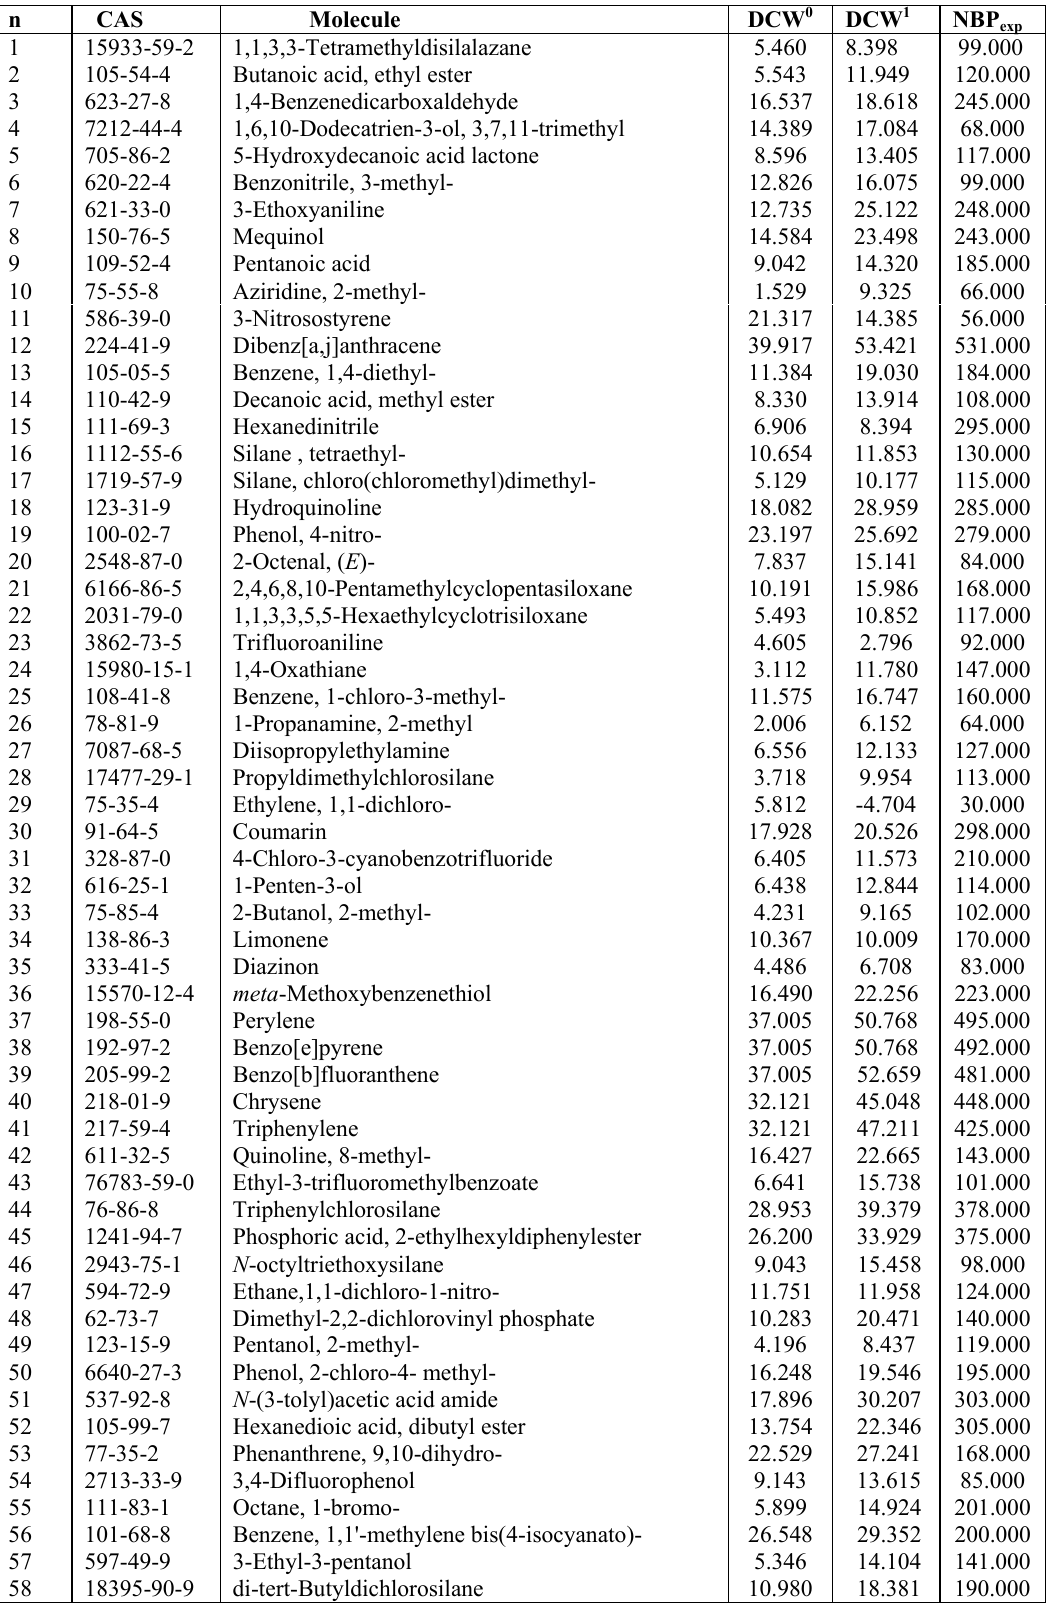
Table 3 . Organic molecules, experimental NBPs (Celsius degrees) and